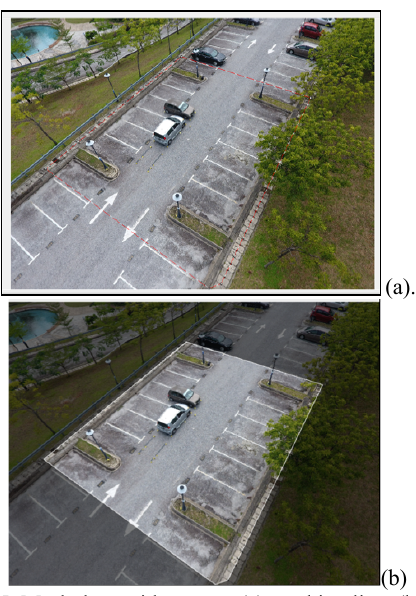
Figure 5. Mask the accident area; (a) masking line, (b) invert selection after